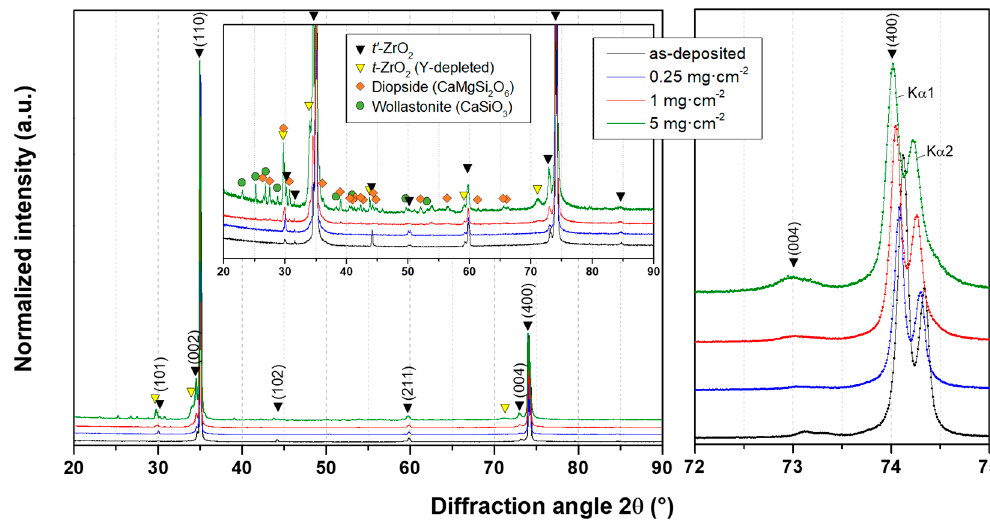
Figure 8. X-ray diffractograms of the 8YSZ standard coatings in their as-deposited conditions and Figure 8. X-ray di ff ractograms of the 8YSZ standard coatings in their as-deposited conditions and after after annealing in air at 1250 °C for 1 h with the different CMAS deposits. annealing in air at 1250 ◦ C for 1 h with the di ff erent CMAS deposits.